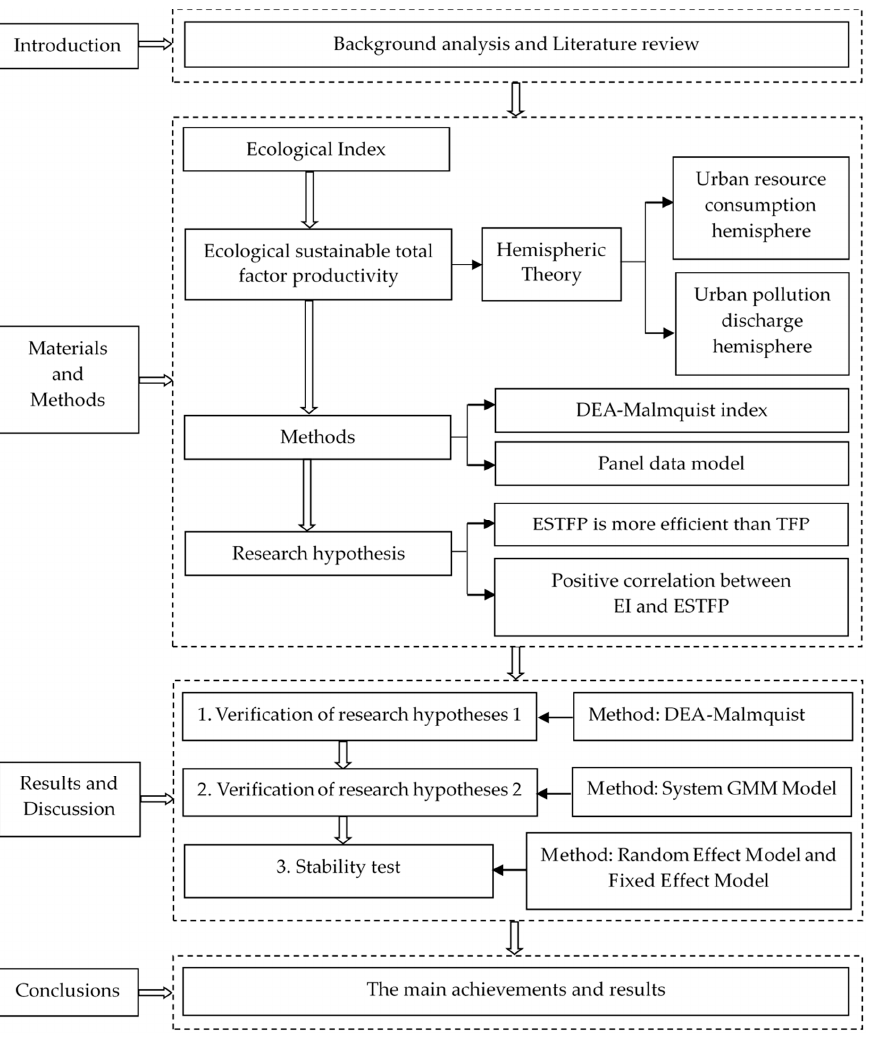
Figure 1. Research